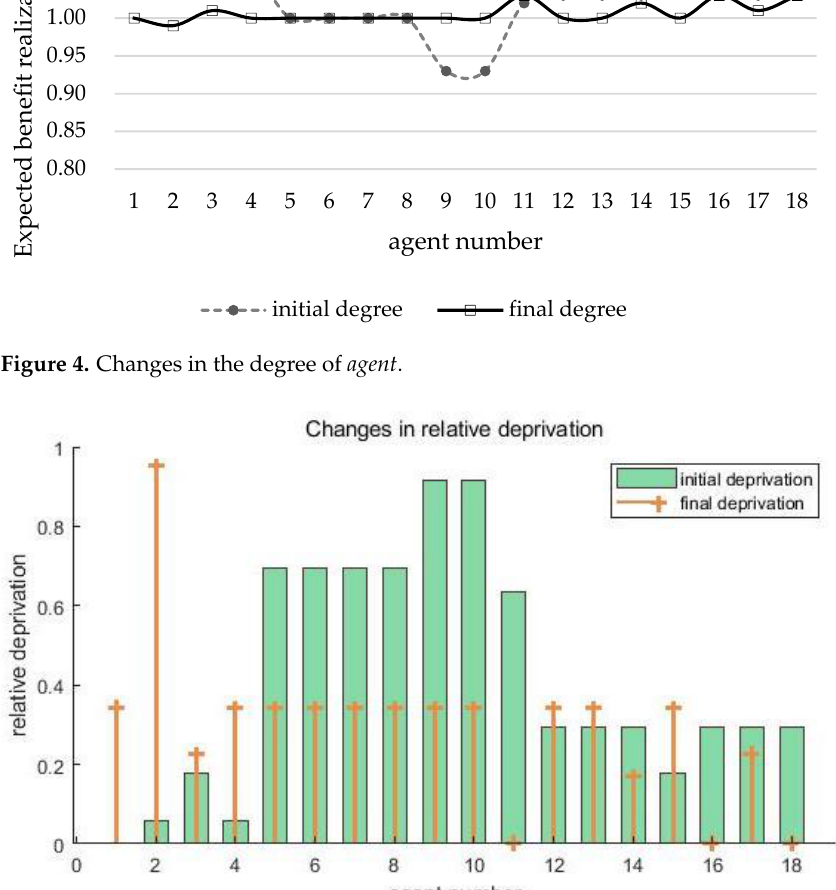
Figure 5. Changes in relative deprivation in agent.